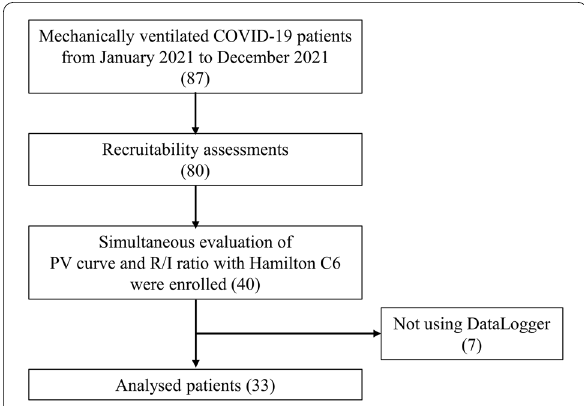
Recruitability assessment of NMD and R/I